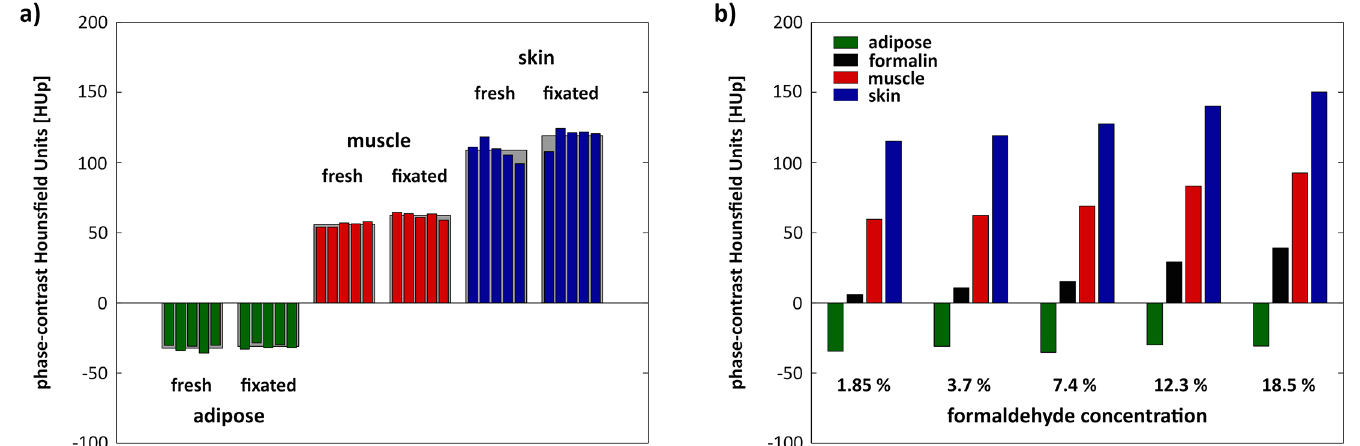
Fig 3. Graphical representation of the quantitative analysis of non-fixated and fixated tissue samples. (a) Comparison of phase-contrast Hounsfield units evaluated for five non-fixated porcine samples, and five samples fixed in 3.7% formaldehyde solution. Formalin fixation does not affect adipose tissue but increases the Hounsfield units of muscle and skin by approximately 10%, most likely by tissue shrinkage. (b) Phase-contrast Hounsfield units of the three investigated tissue types fixated at different formaldehyde concentrations. Again, adipose tissue is insensitive to formaldehyde concentration, but the HUp of muscle and skin follow the same trend as the actual formaldehyde solutions. This effect is due to replacement of water by the formaldehyde solution within the